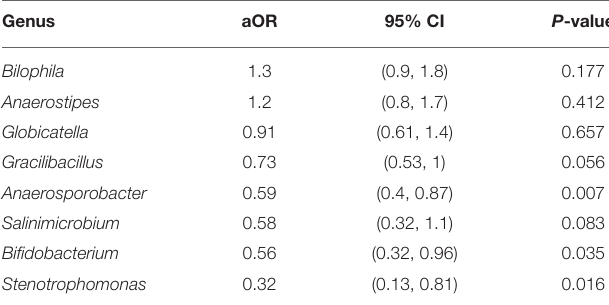
TABLE 4 | Association of differentially abundant bacterial genera with the isolation of Campylobacter . Genus aOR 95% CI P -value Bilophila 1.3 (0.9,